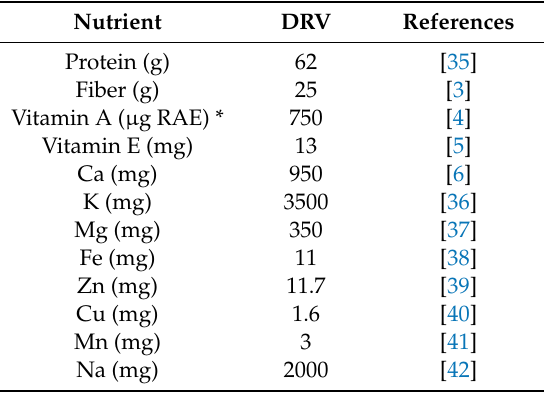
Table 1. Dietary Reference Values (DRV) for selected nutrients used in developing the NQS 11.1. Nutrient